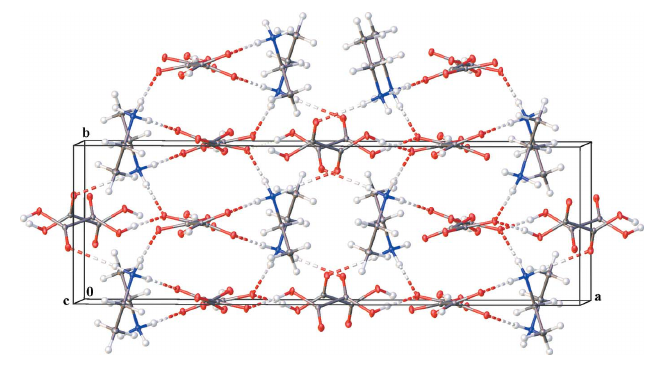
Figure 1 View of the title salt showing the atom-labelling scheme. Displacement ellipsoids are drawn at the 50% probability level. Hydrogen bonds are shown as dotted lines [symmetry codes: (i) x , (cid:3) y , 1 + z ; (ii) 1 (cid:3) x , (cid:3) y , 1 (cid:3) z ; 2 (cid:3) z ; (iv): 3 (cid:3) x , (cid:3) 1 (cid:3) z (iii) 1 (cid:3) x , y , 1 + y , 1 2 2 2 2